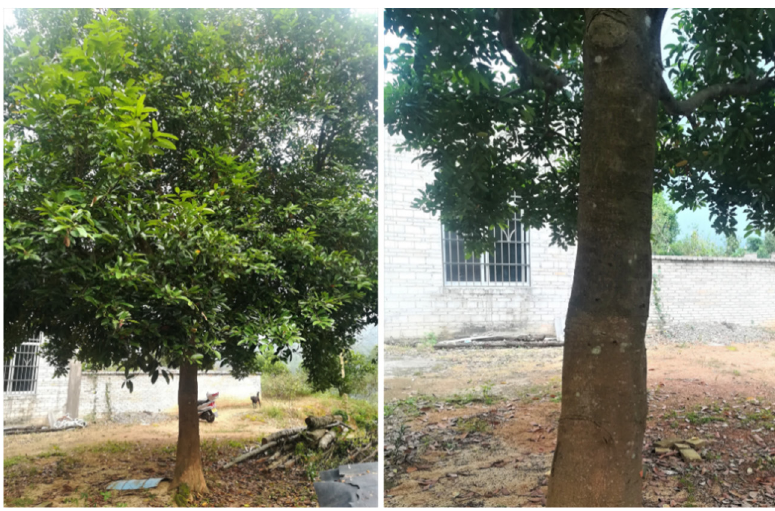
Figure 1. Cinnamomum cassia Presl.